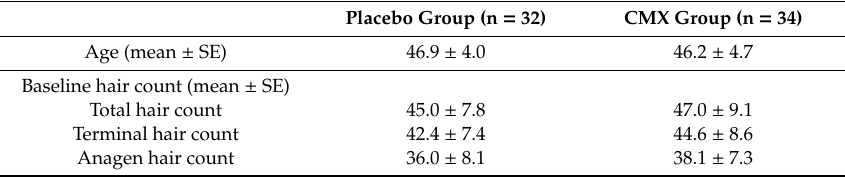
Table 4. Baseline characteristics of placebo group and CMX group.